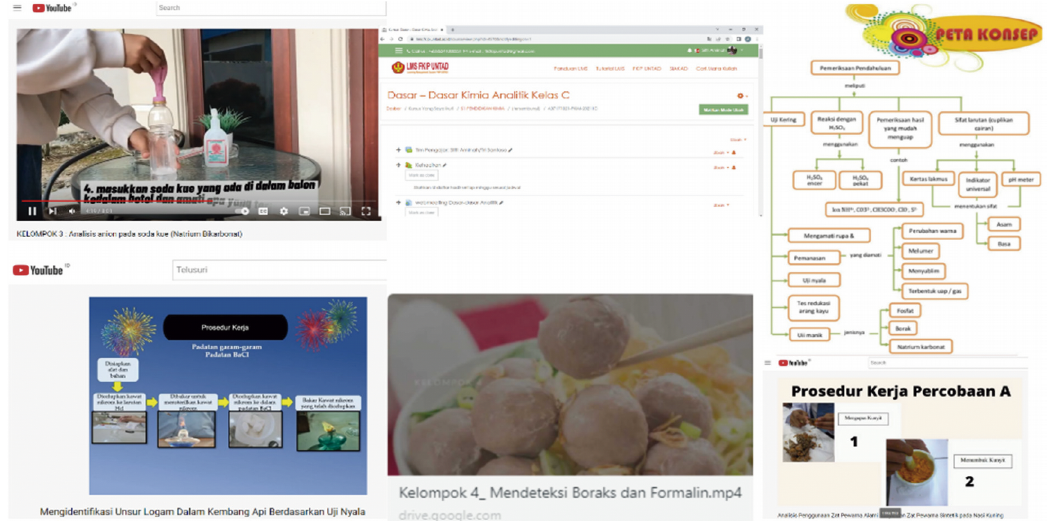
Figure 3. Results of projects done by students in groups for DDKA